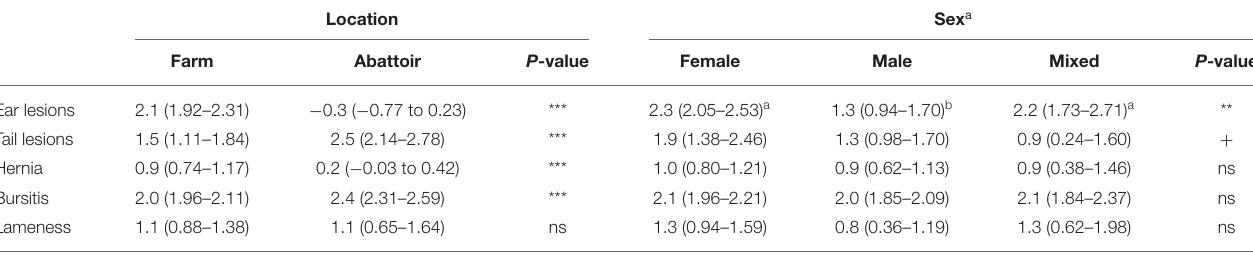
TABLE 3 | Effect of assessment location and animal sex on the prevalence of animal-based welfare outcomes in slaughter pigs assessed on farm (198 pens; 9,049 pigs) and at the abattoir (54 batches; 8,843